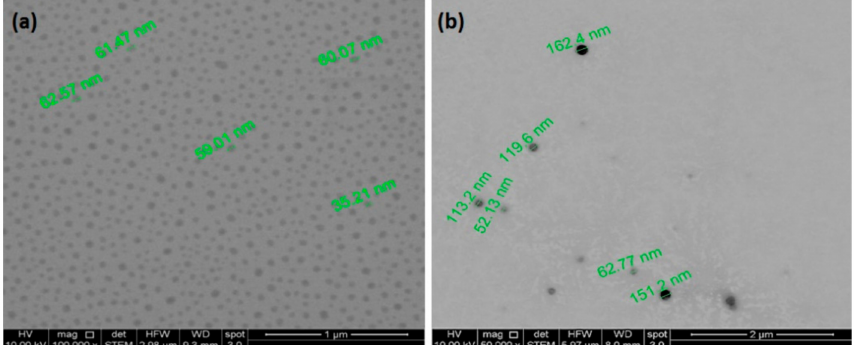
Figure 6. Scanning Electron Microscopy. ( a ) Empty NPs without dilution. ( b ) 4-NC NPs with 10x dilution.